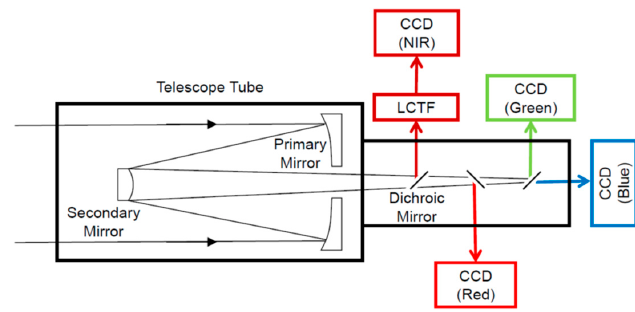
Figure 3. Schematic of the HPT.